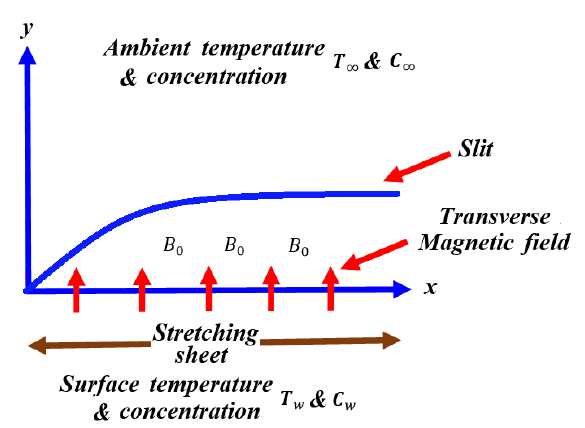
Fig. 1: Schematic of flow